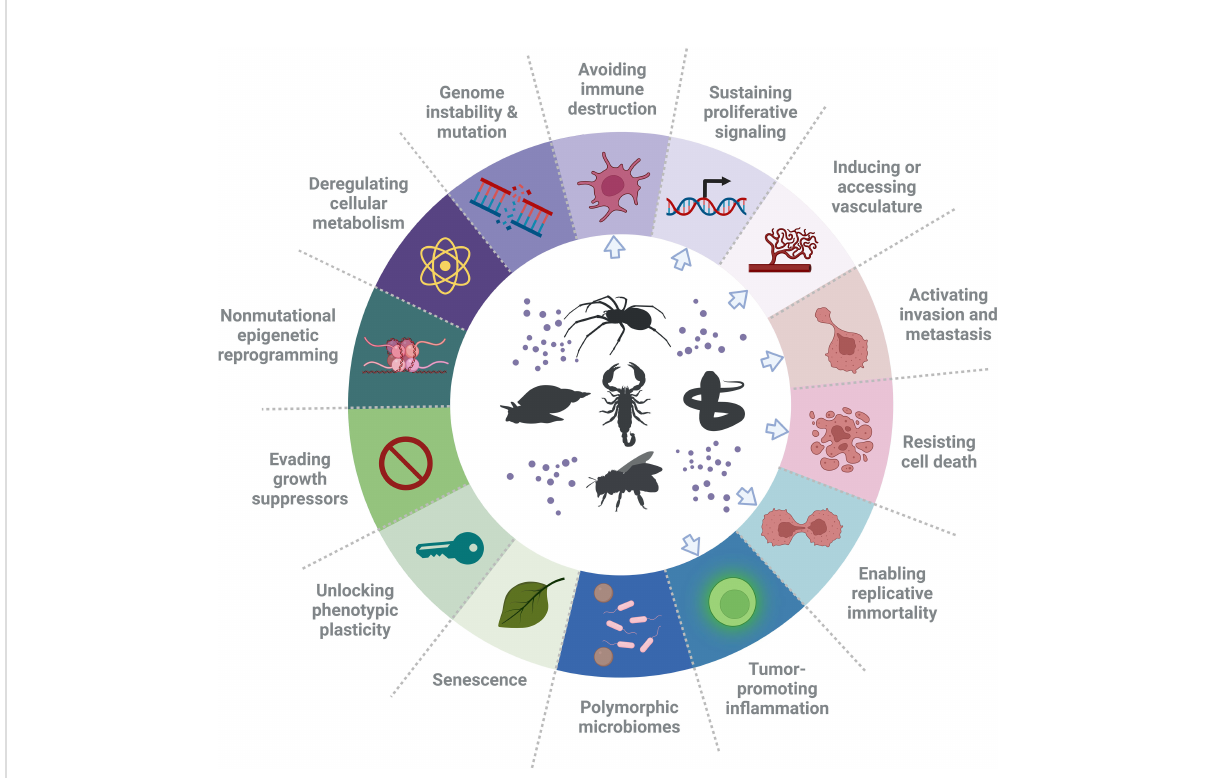
FIGURE 1 Hallmarks of cancer and suggested types of treatments. In the ring, the hallmarks of cancer, as de fi ned by Hanahan and Weinberg (9), are presented. These hallmarks have been identi fi ed as therapeutic targets for new anti-cancer drugs. Noteworthy, there are examples of peptides that have an effect on a single cancer hallmark in various cancers and also have an effect on glioblastoma, or have a speci fi c effect on one cancer. However, a single bioactive peptide can affect more than one hallmark (e.g. invasion and angiogenesis). Blue arrows point at the hallmarks of cancer that have been affected by venom peptides. The fi gure was generated using BioRender online tool, adapted from “ Hallmarks of cancer: circle ” [BioRender.com